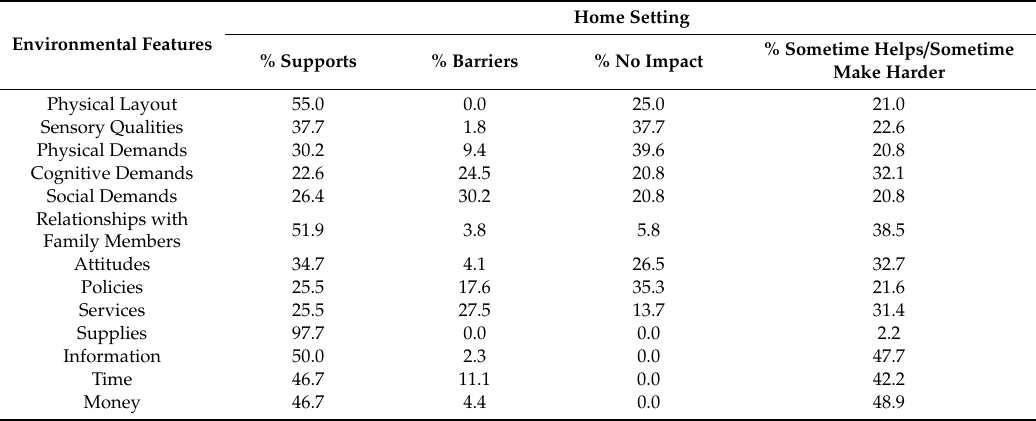
Table 3. Environmental features as perceived by parents at